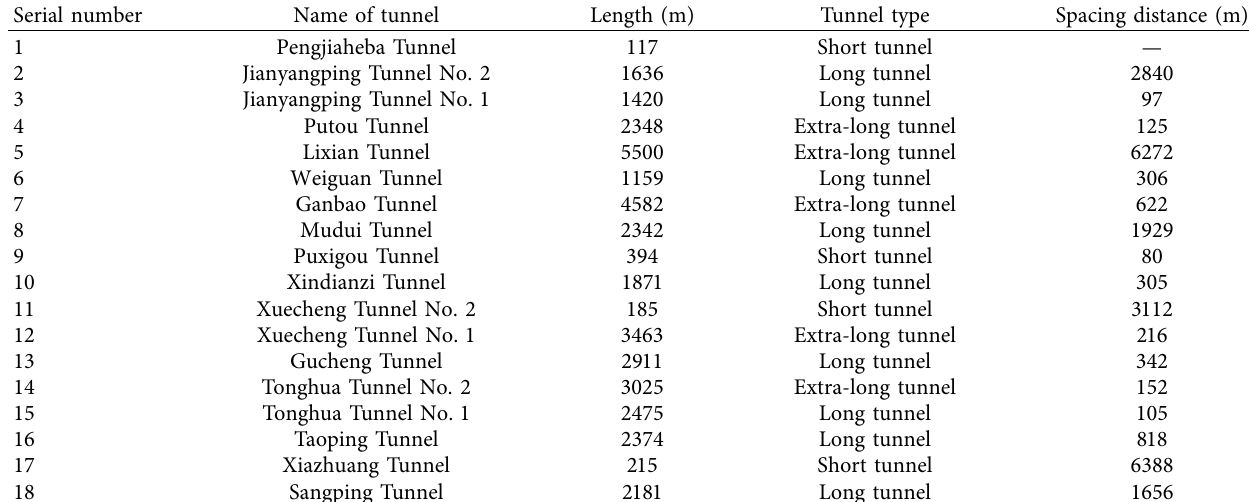
Table 1: Distribution of tunnels.